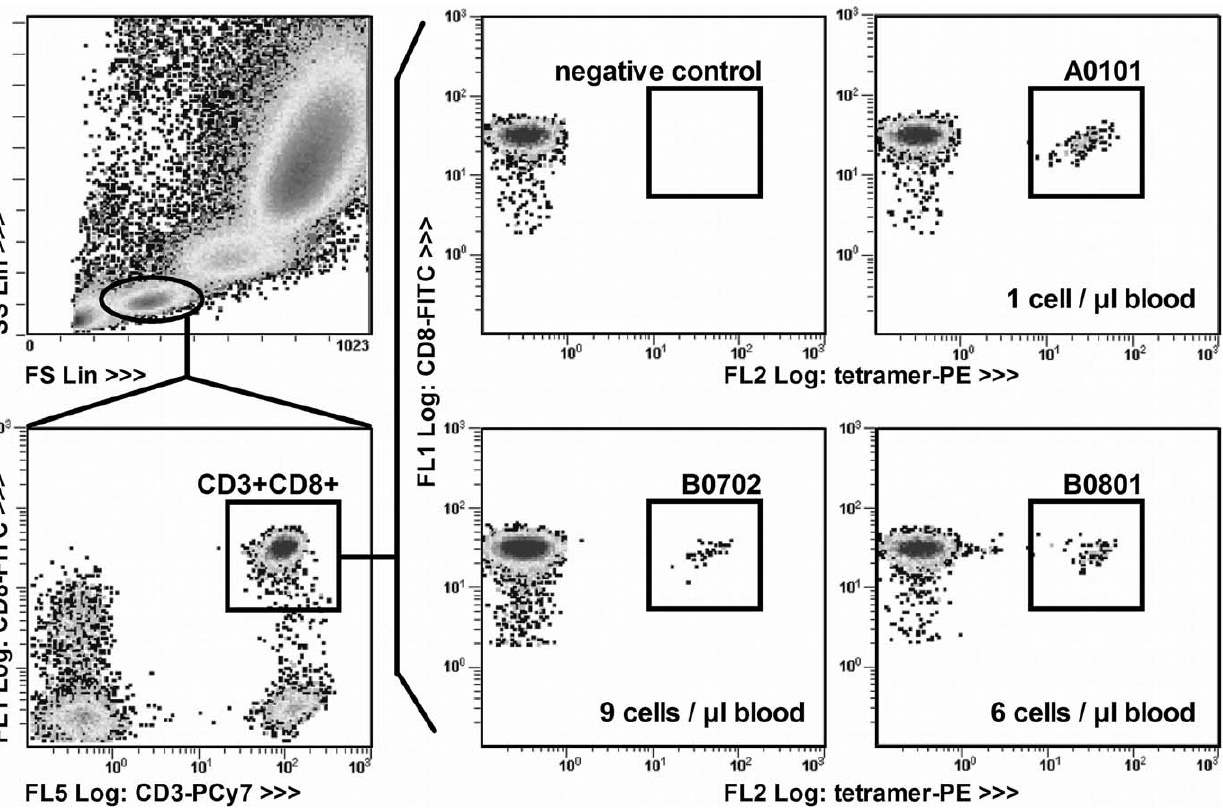
Figure 1. Gating strategy for detection of tetramer-stained CMV-CTLs. The gating hierarchy and tetramer positive cells in a patient expressing 3 of the HLA molecules represented in our tetramer set are shown. The lymphocytes were gated in the FS/SS quadrant (upper left) followed by the selection of CD3 + CD8 + -positive cells (lower left). Within the CD3 + CD8 + -positive population, the percentage of cells that bind each tetramer is determined in individual samples (200 m l whole blood each). Staining results using the negative control tetramer, HLA-A*0101 CMV tetramer, HLA-B*0702 CMV tetramer and HLA-B*0801 CMV tetramer are shown. The number of CMV-CTLs per m l blood is indicated in each tetramer